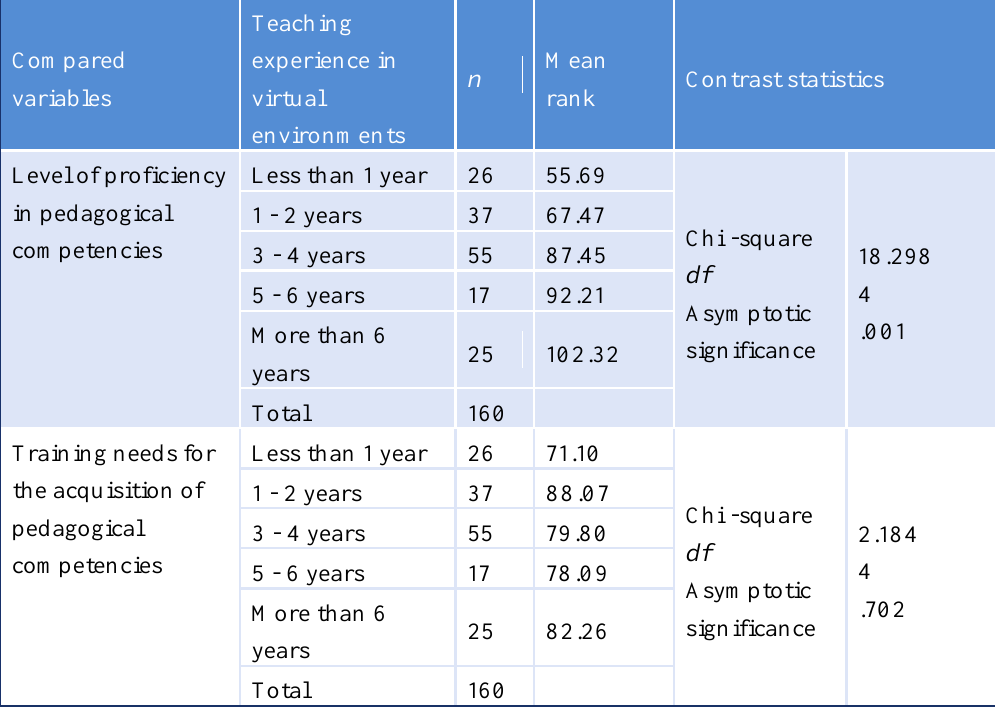
Teaching experience in virtual environments